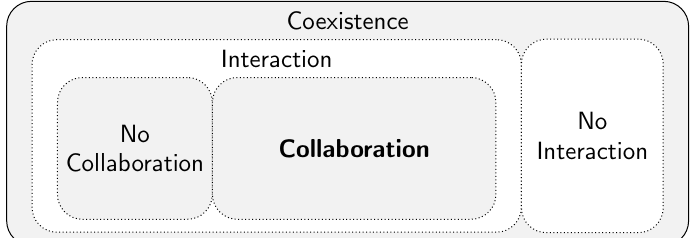
Figure 2. Relations between the different concepts about human-robot